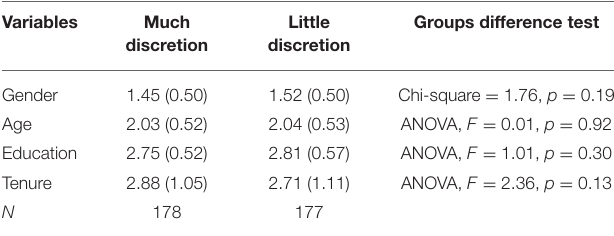
TABLE 2 | Valid sample characteristics (means and standard deviations in parentheses, N = 355). Variables